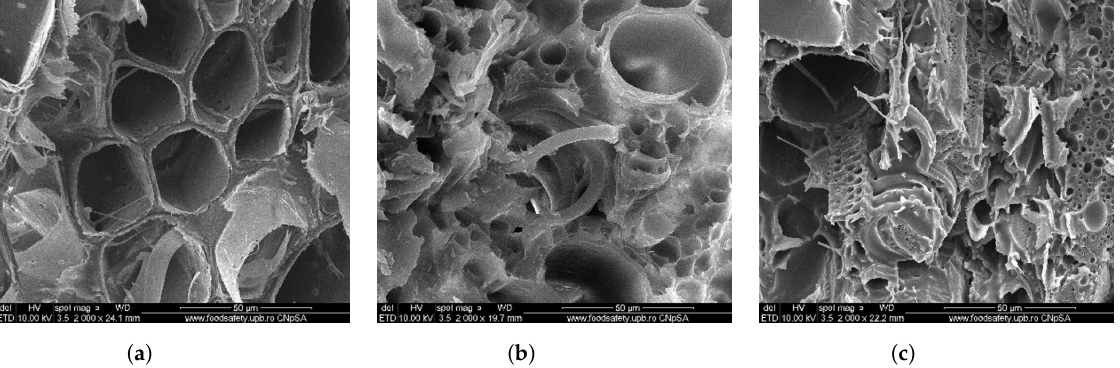
Figure 6. Breaking surface of some representative specimens from the sets: PTE ( a ); PTD5 ( b ); PTD7 ( c